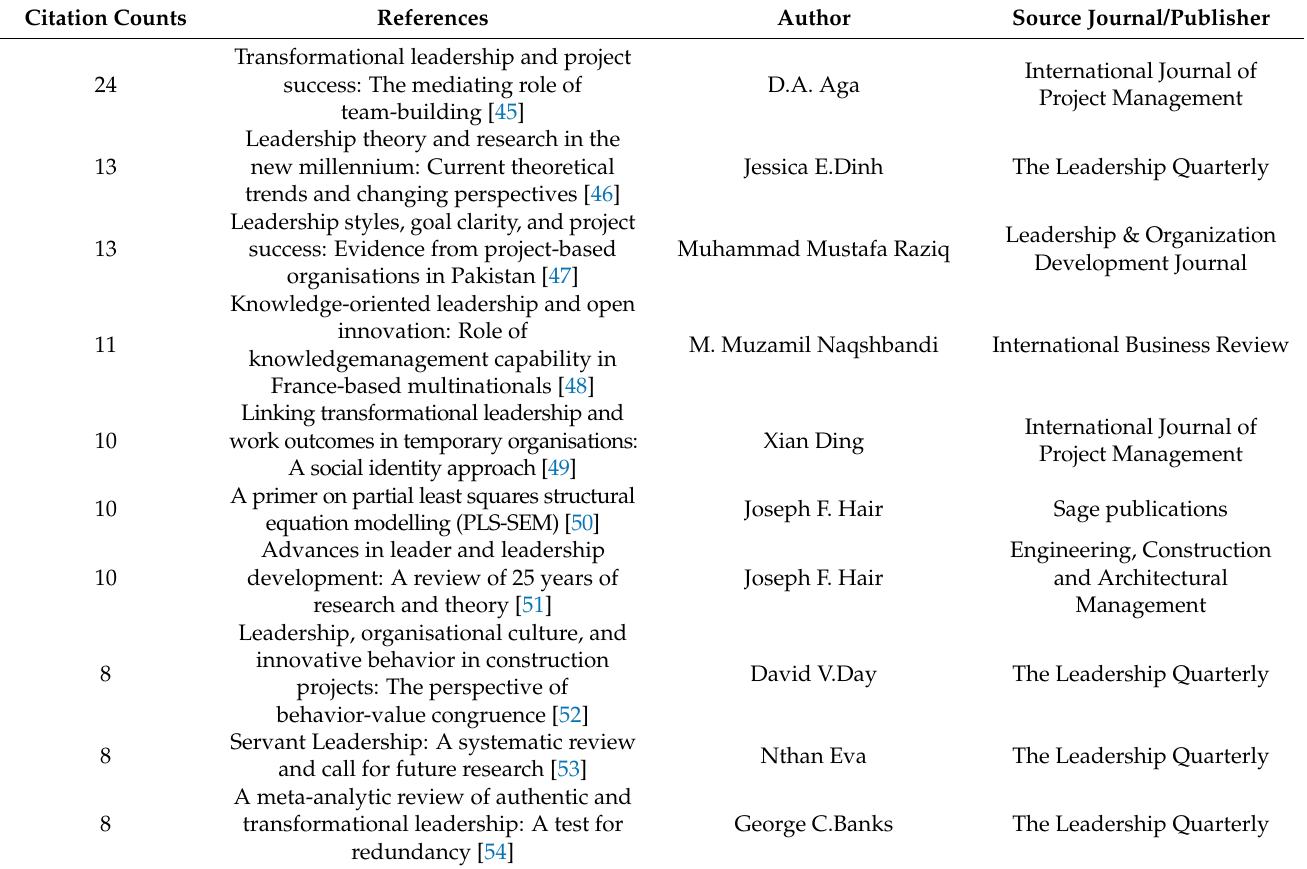
Table 5. Top 10 cited references.